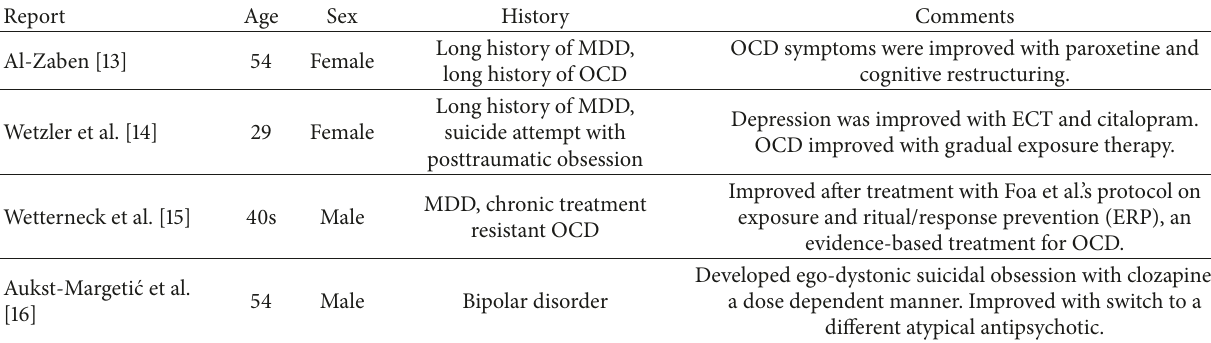
Table 1: Previously published case reports on OCD with suicidal